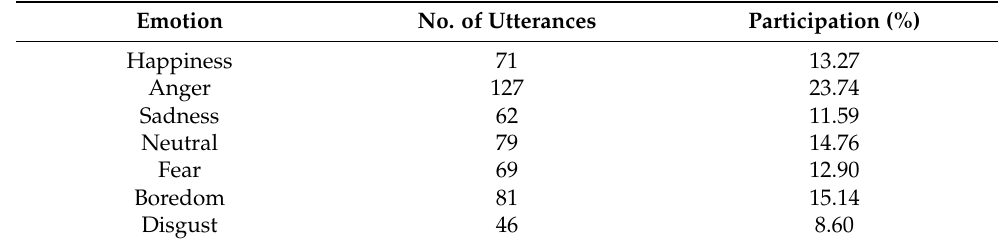
Table 3. The number of utterances in each class and their participation (%) in the EMO-DB